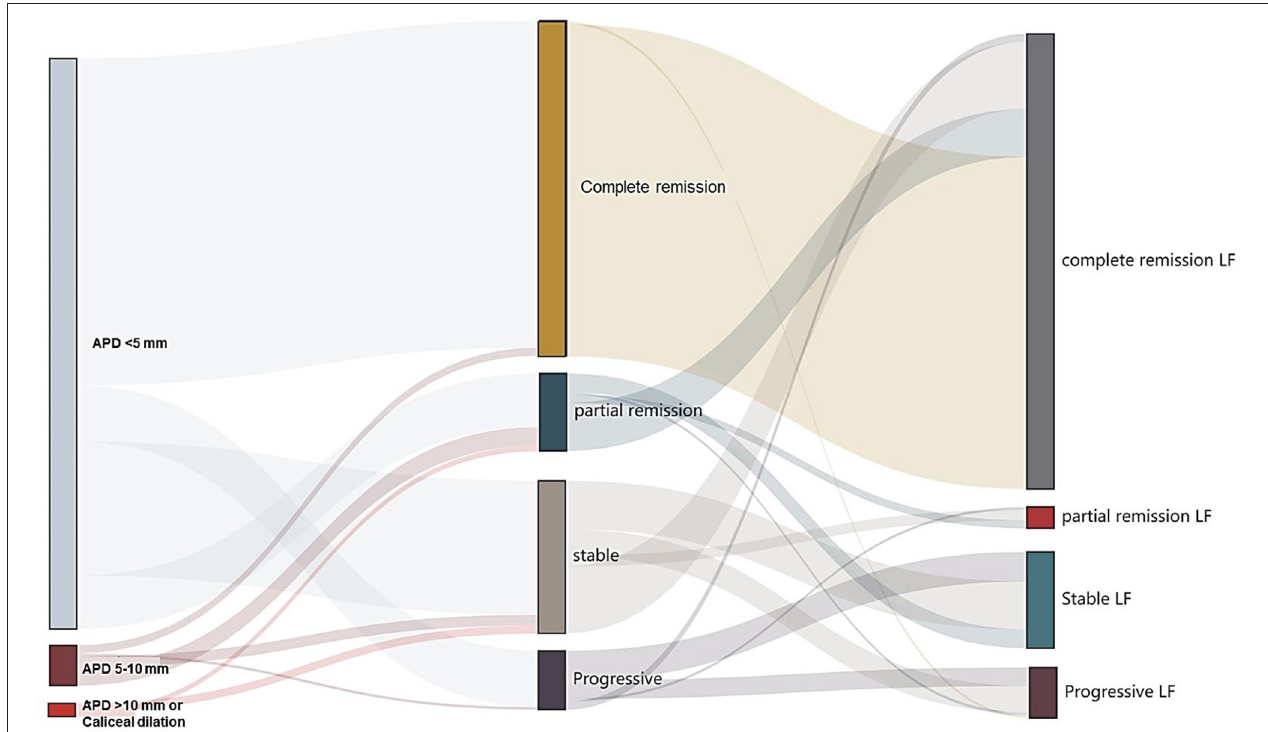
FIGURE 2 | Follow-up of children with urinary tract dilation (UTD). Left and middle: Division of the primary and secondary ultrasound screening results. Middle and right: Division of change in secondary and tertiary ultrasound screening results. The width of the lines in the Sankey plot is proportional to the relative quantity of cases within each group. APD, the anteroposterior diameter of the renal pelvis; LF, the last follow-up.